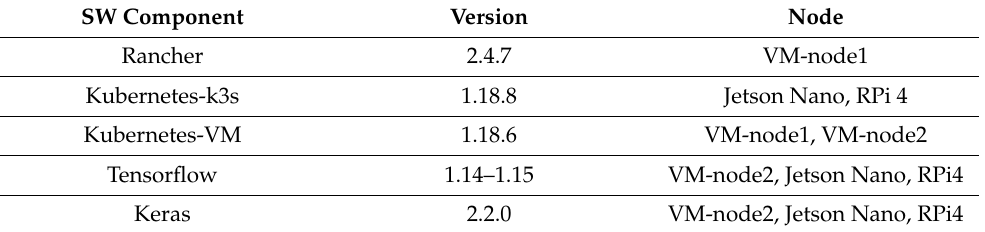
Table A2. SW component versions and nodes, where the components were executed in. SW